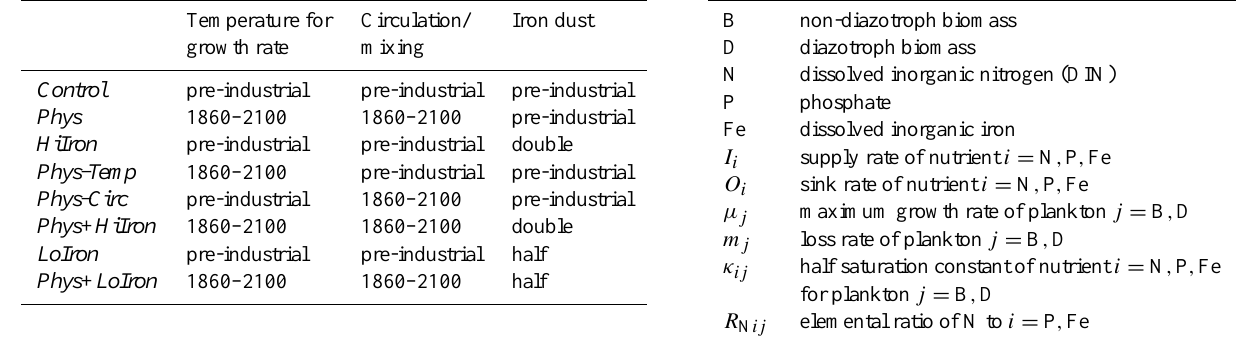
Table 1. Sensitivity experiments. Temperature for